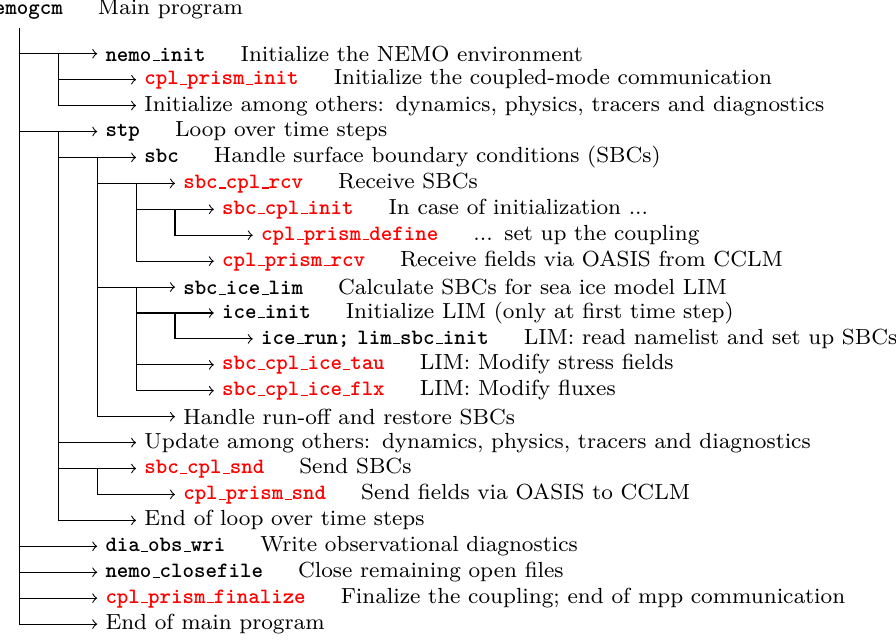
Figure 9. As Fig. 8 but for the NEMO version 3.3 ocean